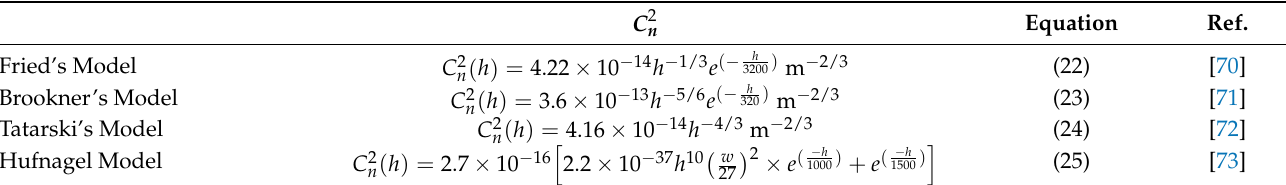
Table 10. Full equations for Fried’s, Brookner’s, and Tatarski’s methods. C 2